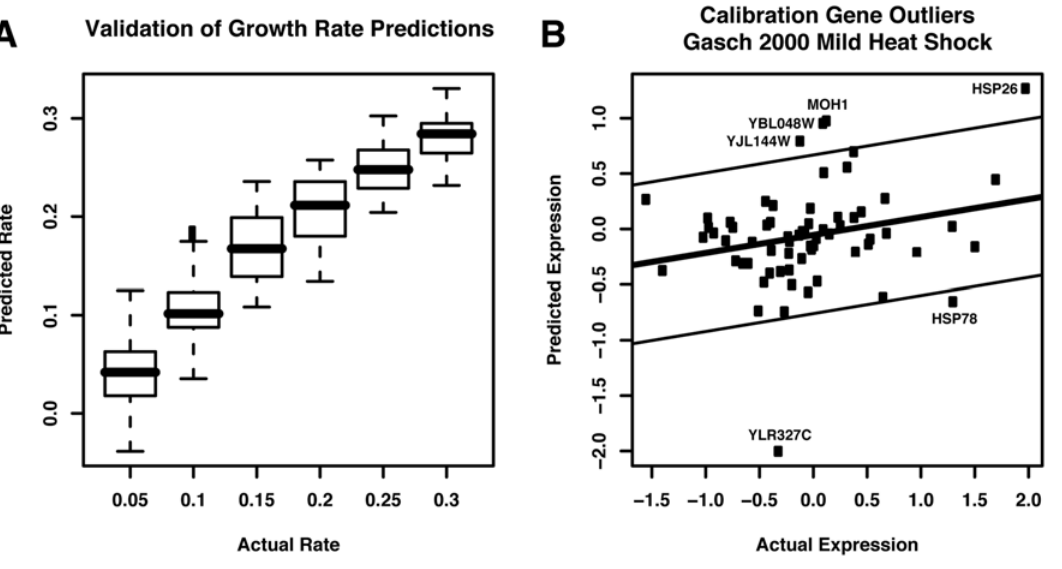
Figure 5. Assessment of accuracy and outlier detection during growth rate inference. (A) We performed an out-of-sample cross-validation of our model by randomly sub-sampling 24 of the 36 training expression arrays 1,000 times. We refit our linear model in each random sample, calculated bootstrapped null distributions for all gene parameters, and found sets of the most significant growth-specific genes. These were then used to infer growth rates for the 12 held-out conditions, providing an estimate of the accuracy of the model’s growth rate predictions. (B) When predicting the growth rate of a new collection of expression data, our model excludes any calibration gene with an expression level outside the inner fence (1.5 times the inter-quartile range below or above the first or third quartiles). This improves predicted growth rate accuracy while also calling out genes potentially responding to specific non-growth stimuli under some biological condition. For example, in the [6] mild heat shock time course, two of the six outliers are known heat shock genes (HSP26 and HSP78). The other four (YLR327C, MOH1, YBL048W, and TMA10) are uncharacterized genes, suggesting potential roles in the response to heat shock.